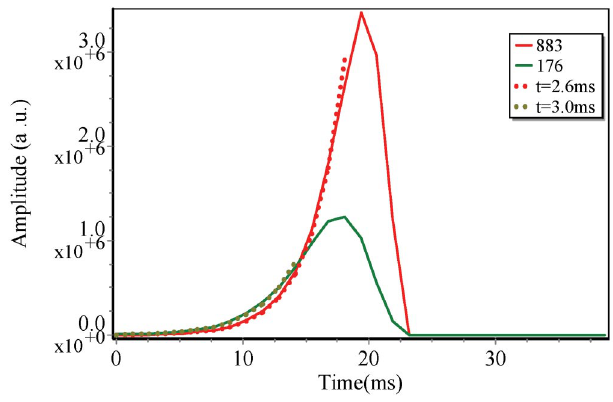
FIG. 6. (Color) Growth of two typical modes and their fitted results.